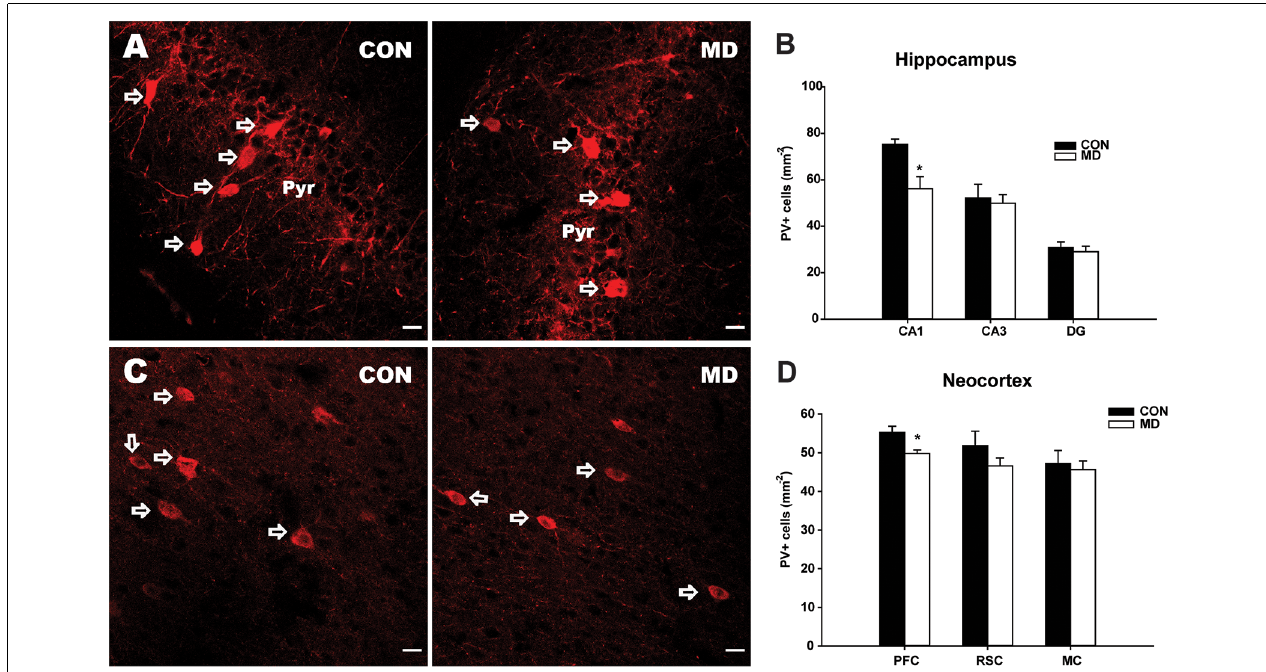
FIGURE 1 | Parvalbumin-expressing interneurons. (A) Representative images of immunofluorescence staining for parvalbumin in the CA1 region of the hippocampus of a control (CON, left panel) and an maternal deprivation (MD; right panel) rat at P60. Pyr indicates a pyramidal cell layer. (B) Shown are mean values + standard error of the mean (SEM) for profile densities (number of immunopositive cells per area) of parvalbumin+ neurons in the hippocampus. (C) Representative images of immunofluorescence staining for parvalbumin in the prefrontal cortex of a CON (left panel) and an MD (right panel) rat at P60. (D) Shown are mean values + standard error of the mean (SEM) for profile densities (number of immunopositive cells per area) of parvalbumin+ neurons in the neocortex (* p < 0.05, t -test, n = 6 animals per group). Scale bars: 20 µ m.